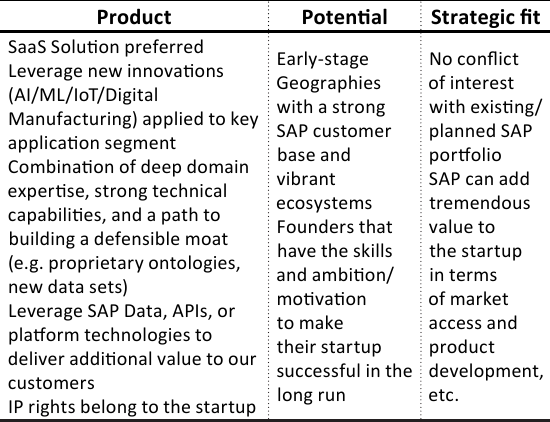
Table 2. Required characteristics of